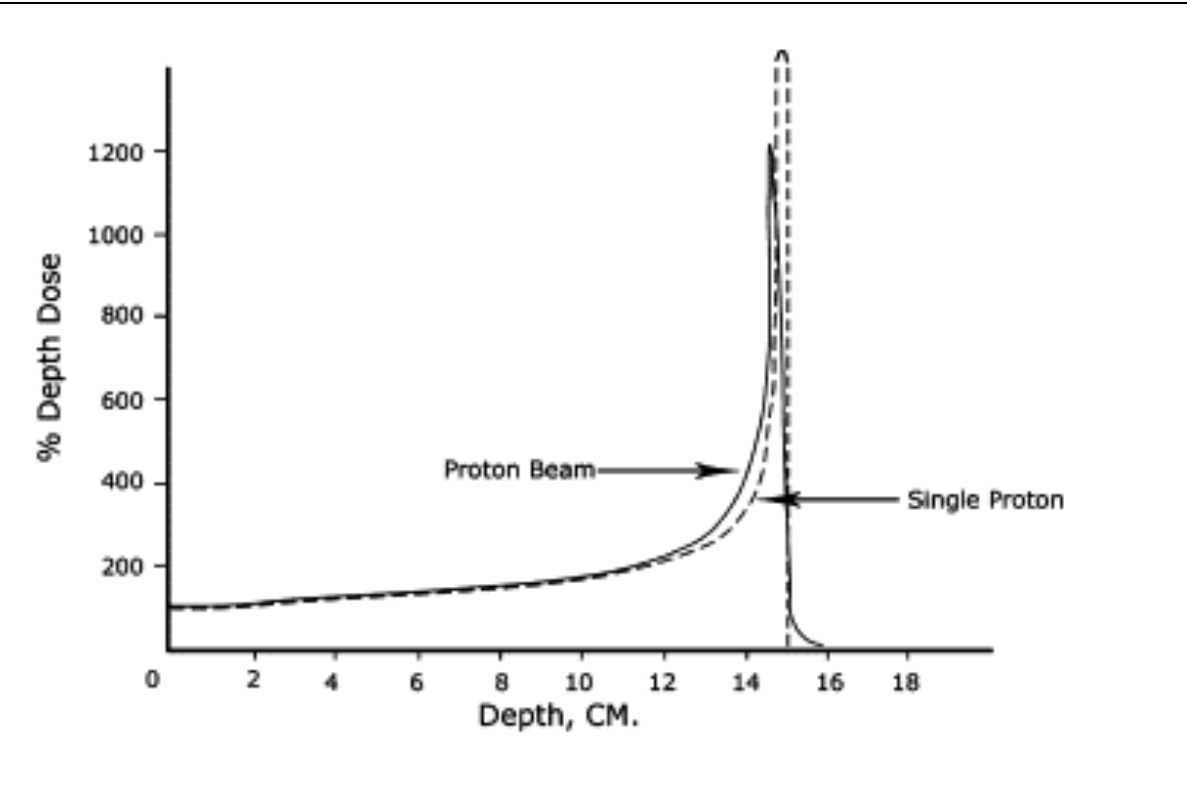
Figure 2. Particle therapy facilities in clinical operation as of October 2022.